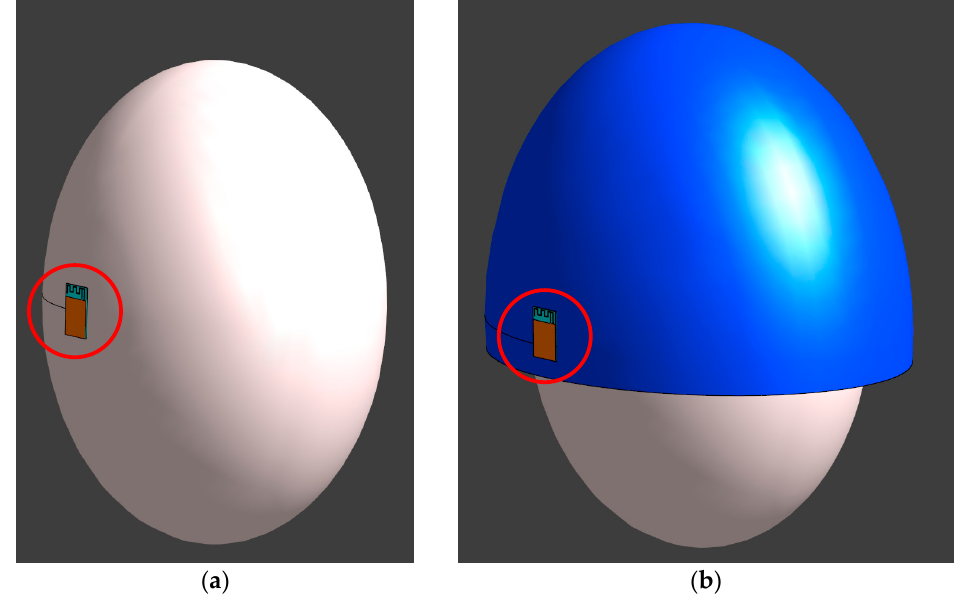
Figure 6. Exposure scenarios with the RF module located ( a ) on the headband; ( b ) attached to a helmet (the RF module is circled).